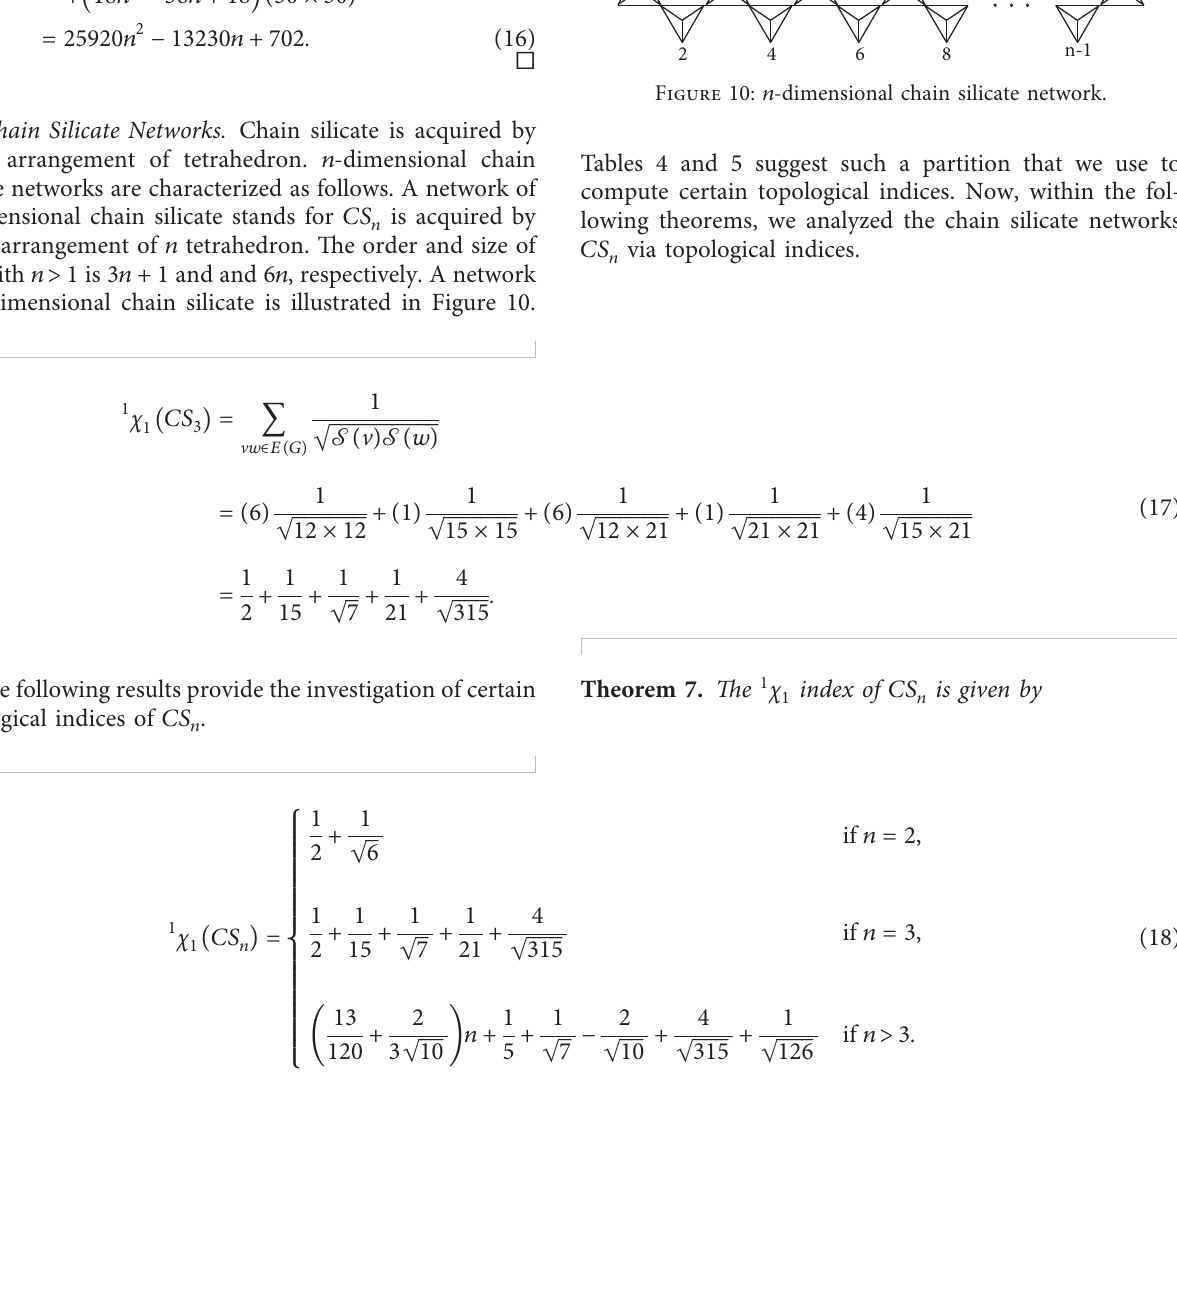
Figure 10: n -dimensional chain silicate